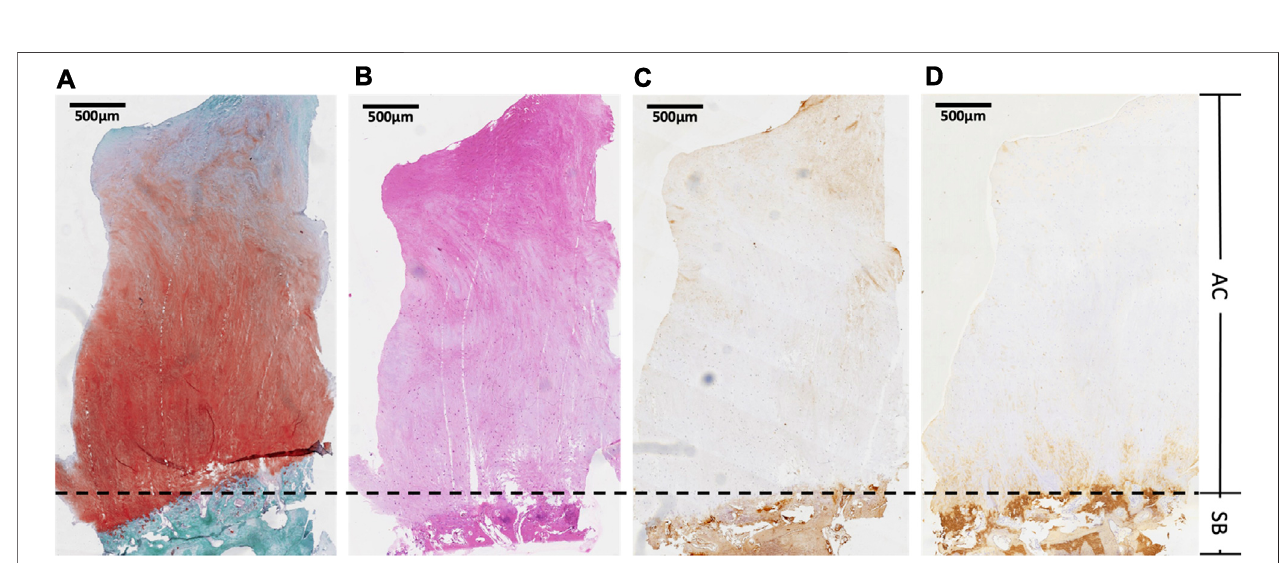
FIGURE 7 | Histologic evaluation. The sample was taken from second-look arthroscopy performed 12 months after the operation. AC, articular cartilage; SB, subchondral bone (A) safranin O-fast green (S-O) stain for glycosaminoglycan distribution, (B) hematoxylin and eosin (HE) stain to observe general cell morphology, (C) immunohistochemically (IHC) with type-speci fi c antibodies against collagen type I (D) immunohistochemically (IHC) with type-speci fi c antibodies against collagen type II to evaluate collagen distribution of regenerated cartilage.